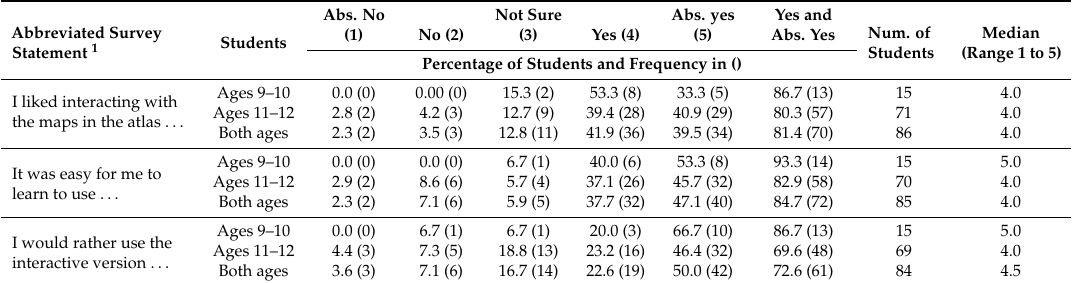
Table 2. Responses of students ages 9–10 and 11–12 to statements about engagement with the earthquakes story